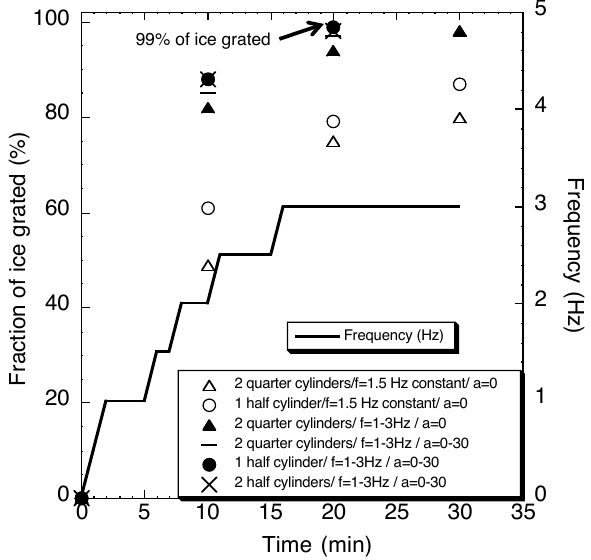
Fig.2: Grating of twenty-­‐two ice core samples of different length and different 787 Fig. 2. Grating of twenty-two ice core samples of different length shapes at various frequencies and shaking angles (a). “a” is the angle between 788 and different shapes at various frequencies and shaking angles (a) . the horizontal plane and the cross section of the SS pot. The error estimate 789 “a” is the angle between the horizontal plane and the cross section (smaller than the data-­‐points) includes the error of the scale and the spread from 790 of the SS pot. The error estimate (smaller than the data-points) repeated tests. 791 includes the error of the scale and the spread from repeated 792